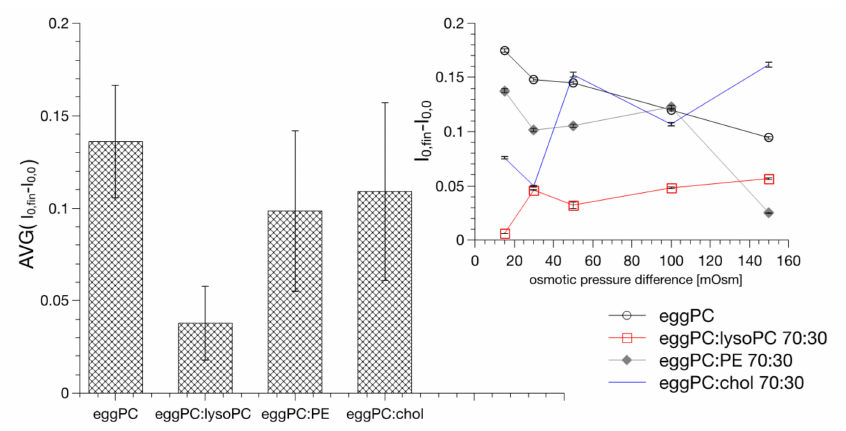
Figure 5. The effect of lipid composition of liposomes on the averaged values of initial drops of light scattering